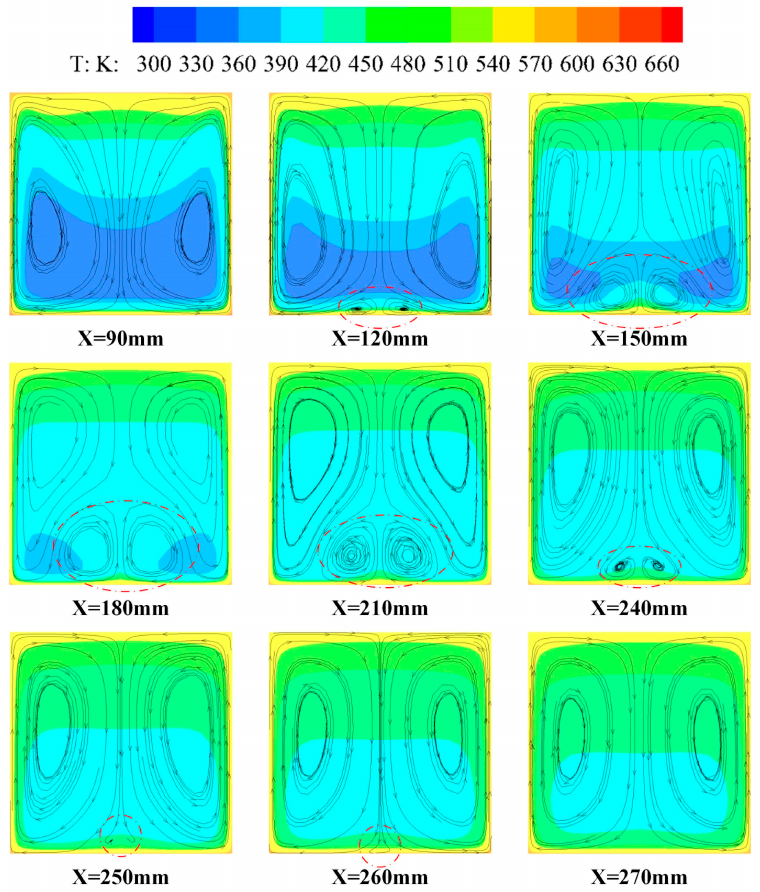
Figure 11. The streamline diagram of the cross section at different positions in case B.